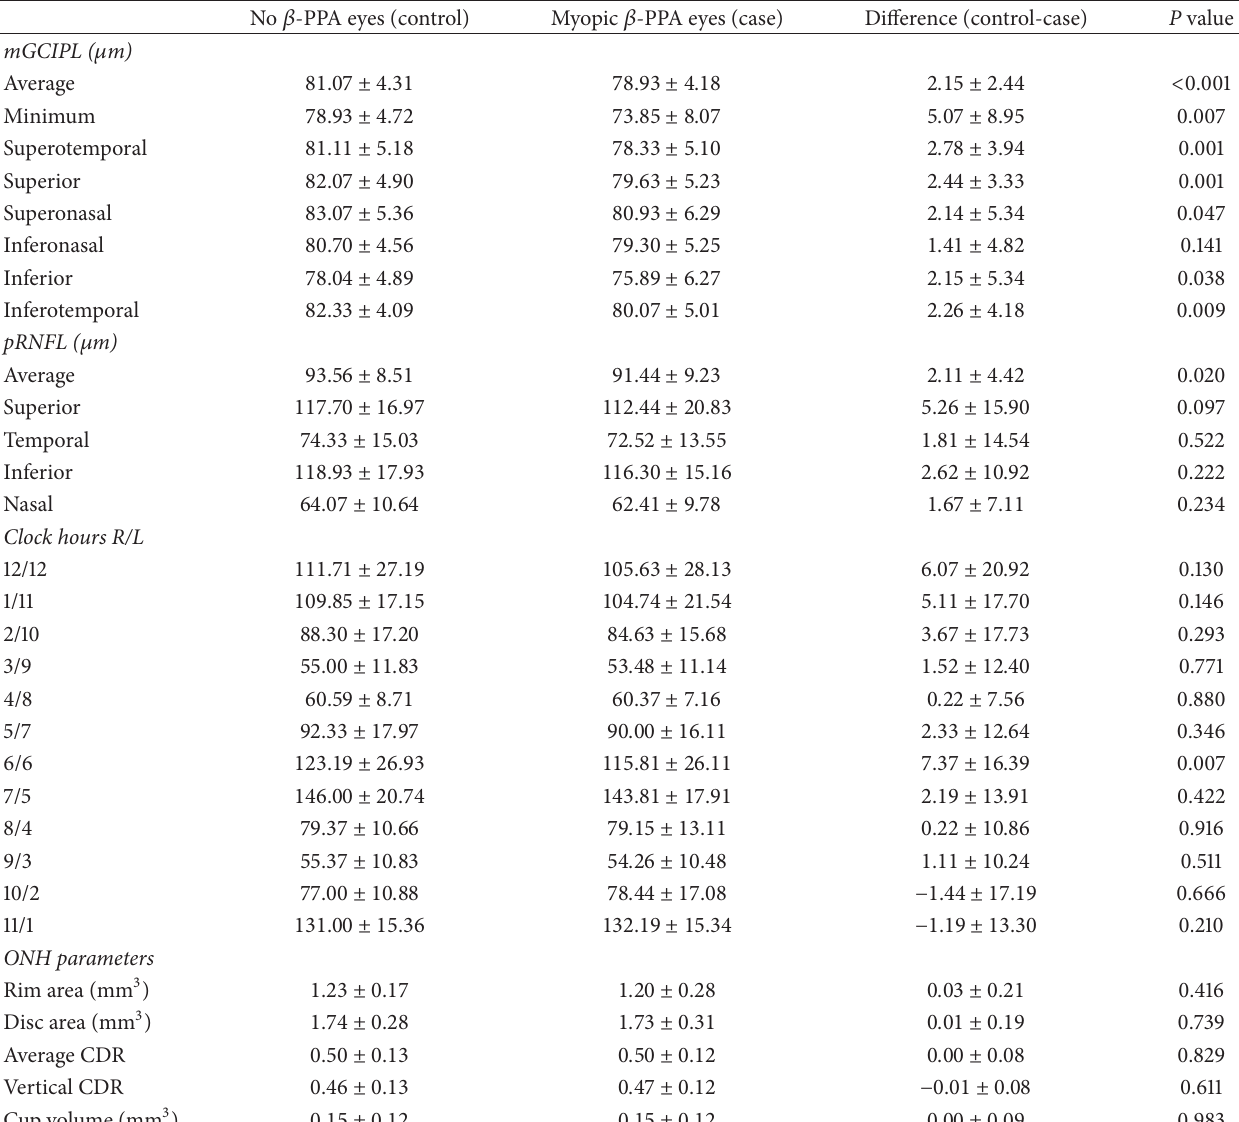
Table 2: Macular GCIPL, pRNFL thicknesses, and ONH parameters.